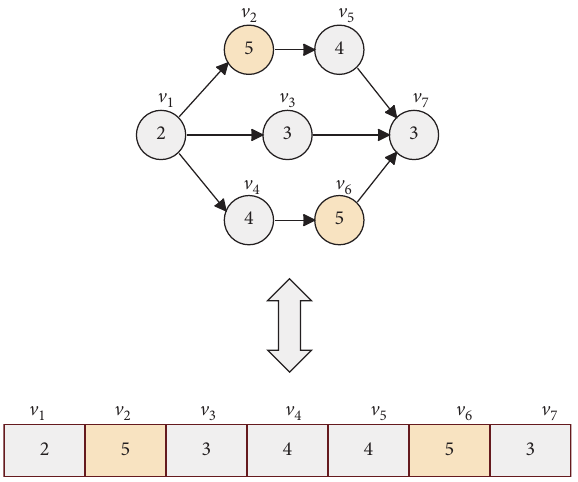
Figure 2: Gene coding process.